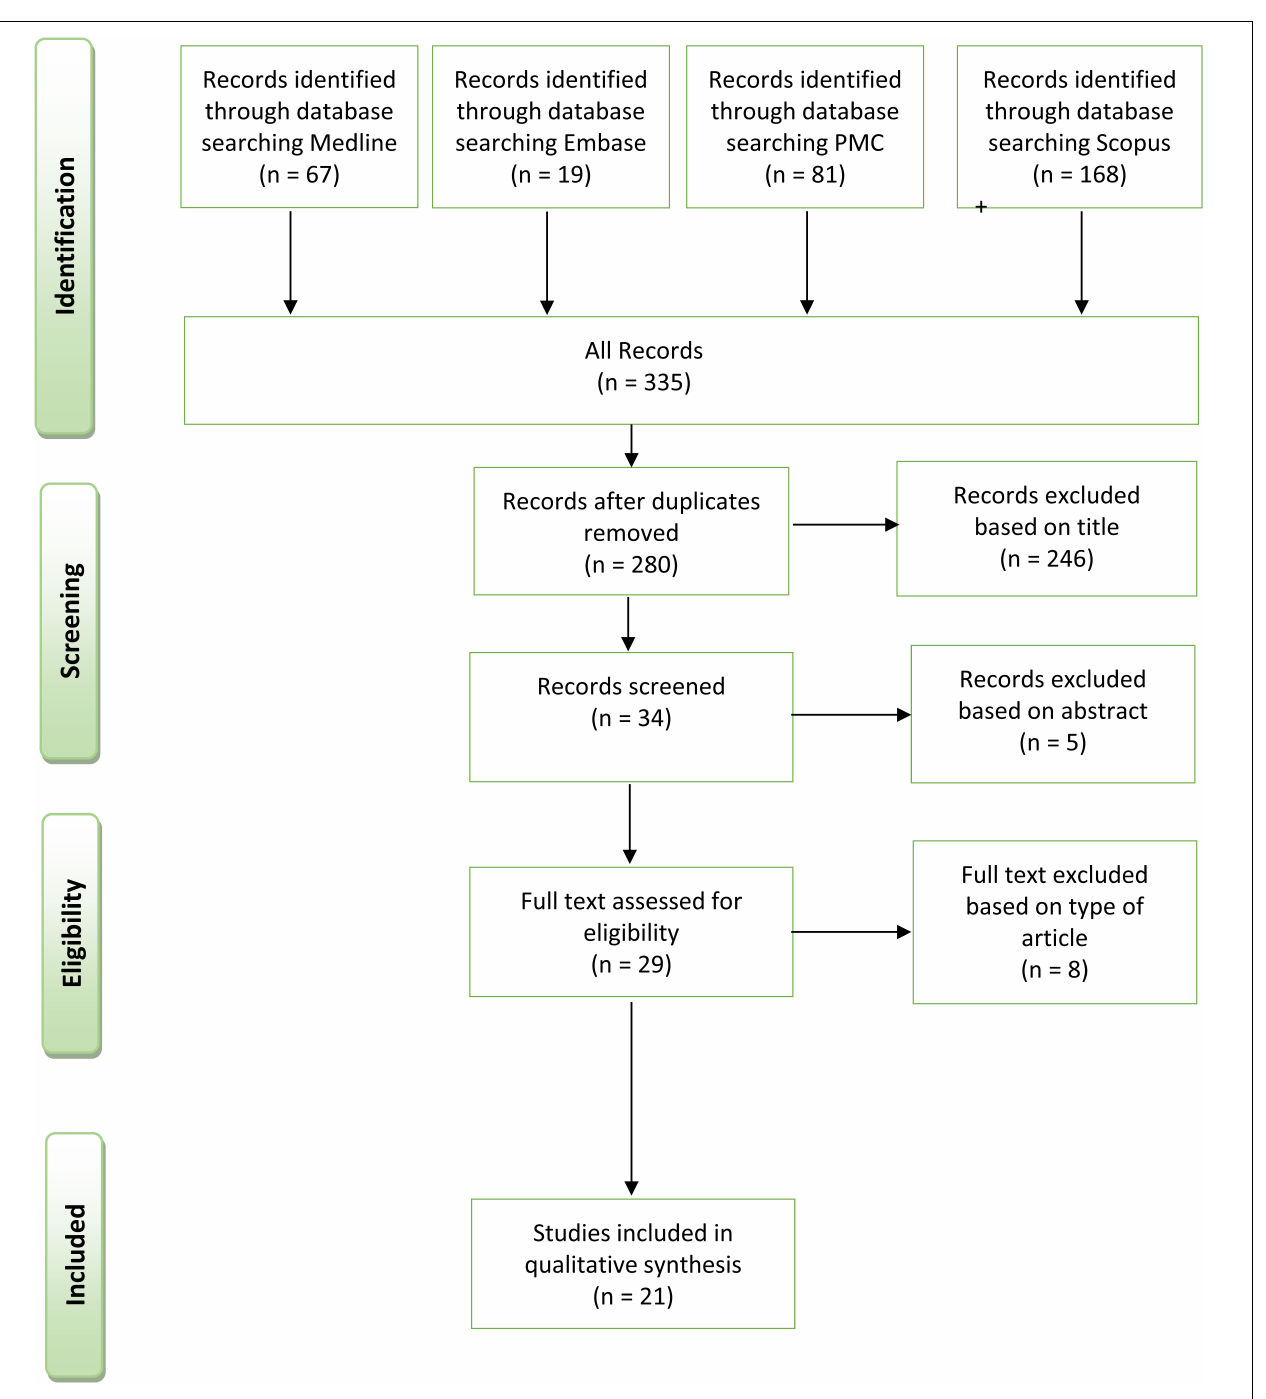
FIGURE 1 | Preferred reporting items for systematic reviews and meta-analyses